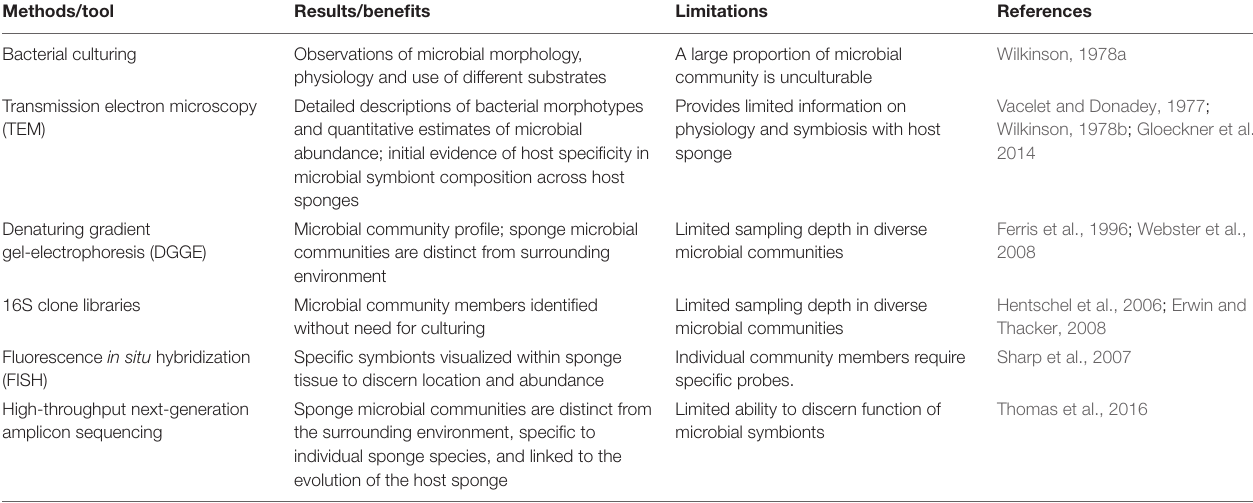
TABLE 1 | Methods for assessing microbial community abundance and composition.